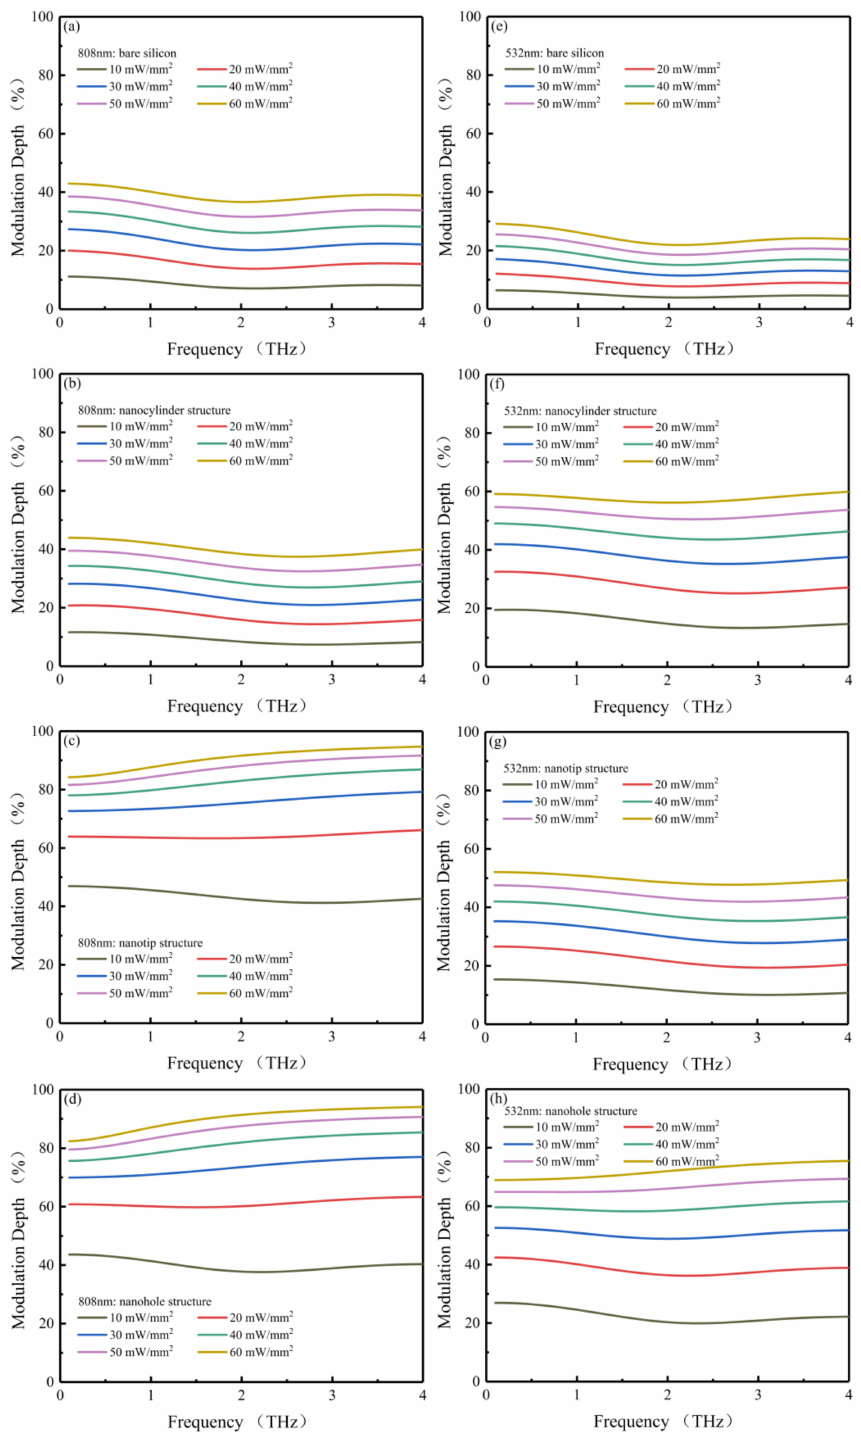
Figure 5. The frequency-resolved modulation depths (0.1~4 THz) of bare silicon, nanocylinder, nanotip, and nanohole structures with 808 ( a – d ) and 532 nm ( e – h ) pump beams,